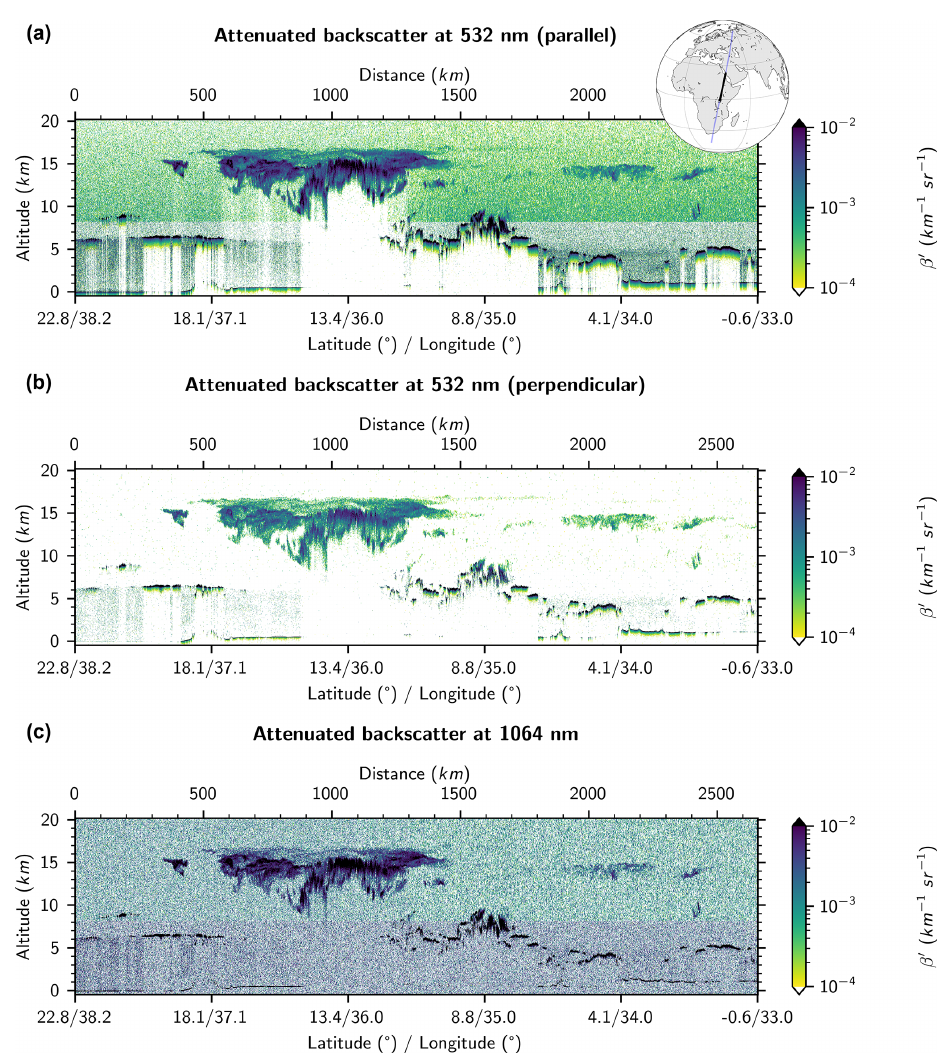
Figure 10. Curtain of attenuated scattering ratios measured by CALIOP during nighttime observations on 31 August 2018, 23:25:54UTC (start point), over Ethiopia at (a) 532nm parallel, (b) 532nm perpendicular and (c)